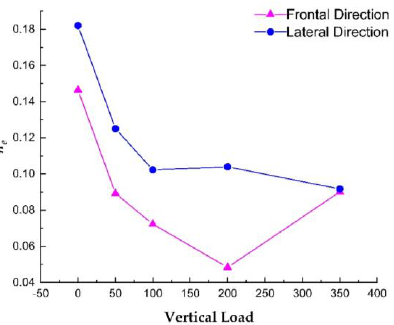
Figure 12. Energy dissipation in the frontal direction and lateral